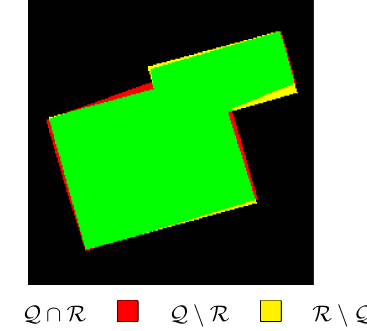
Figure 11. Comparison of both acquisitions (constrained R and unconstrained Q